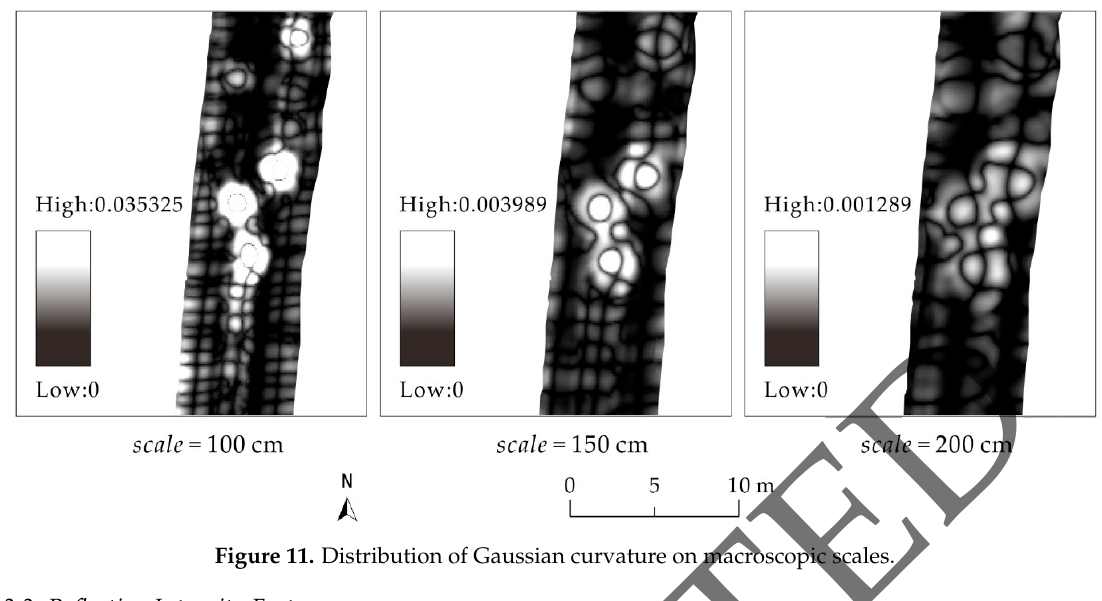
Figure 11. Distribution of Gaussian curvature on macroscopic scales.